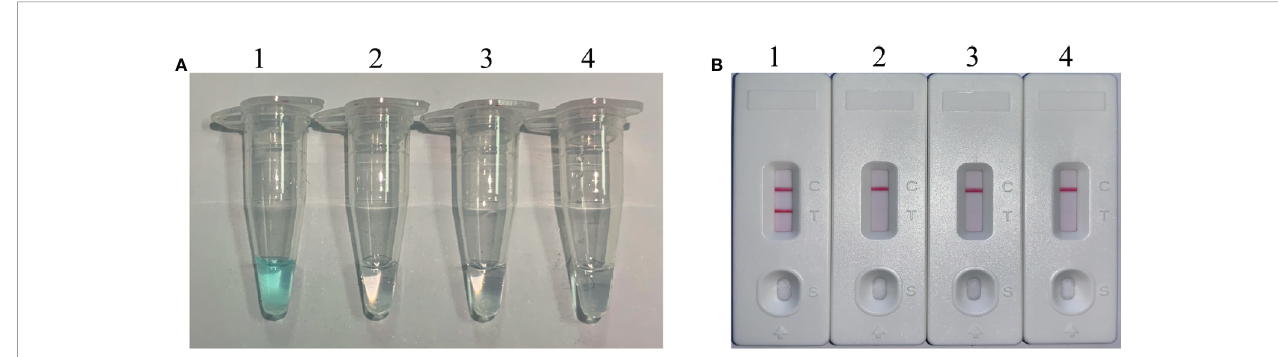
FIGURE 2 | Identi fi cation and con fi rmation of H . in fl uenzae -MCDA products. (A) The visible color changes of ampli fi cation products of H . in fl uenzae -MCDA assay were analyzed by VDR. (B) The products of H . in fl uenzae -MCDA were visually detected with Lateral fl ow biosensor. Tube 1/biosensor 1, positive ampli fi cation of H . in fl uenzae strain; tube 2/biosensor 2, negative control of Staphylococcus aureus strain; tube 3/biosensor 3, negative control of Escherichia coli strain; tube 4/ biosensor 4, blank control (double-distilled water, DW).